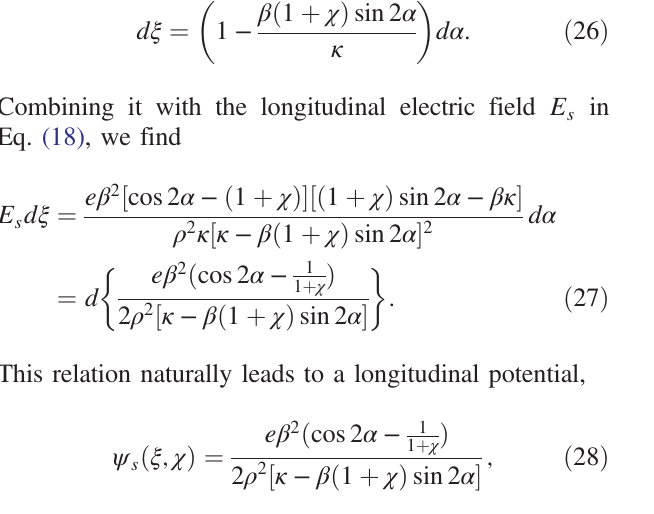
FIG. 4. The scaled longitudinal potential ψ with γ ¼ 500